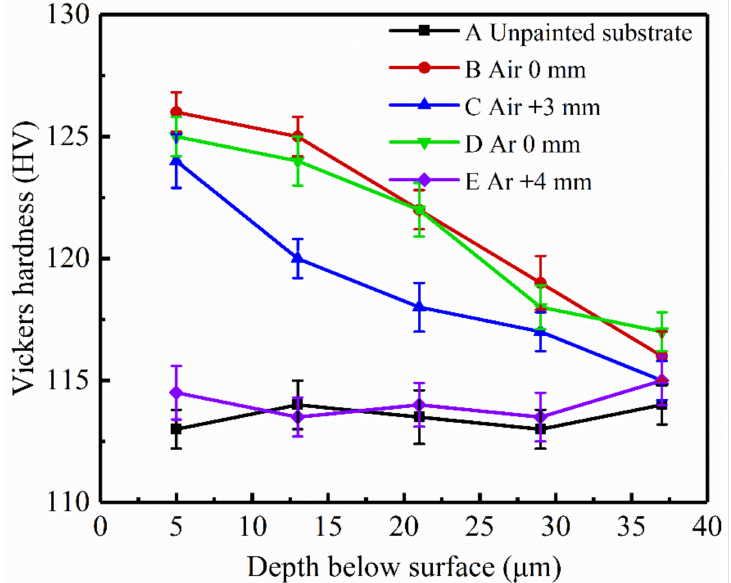
Figure 14. Microhardness depth profile of t unpainted substrate and laser treated samples: ( A ) unpainted substrate; ( B ) in ambient air, focused; ( C ) in ambient air, defocus distance +3 mm; ( D ) in inert atmosphere, focused; ( E ) in inert atmosphere, defocus distance +4